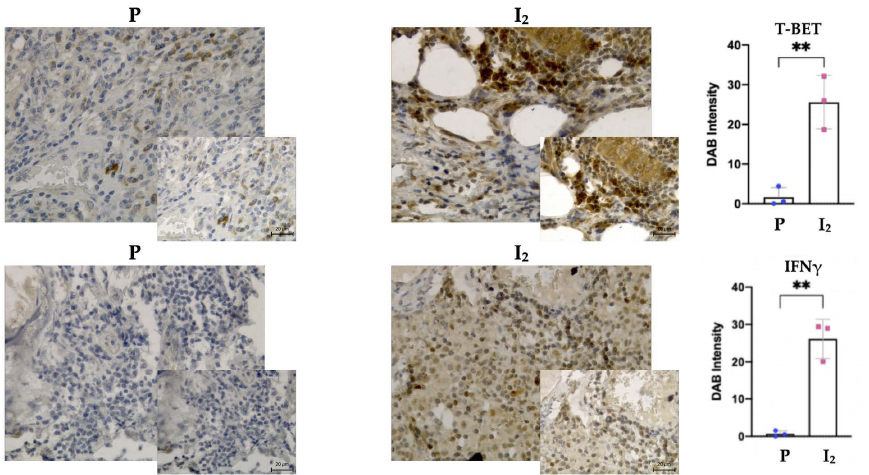
Figure 4. Protein expression of T-BET and IFN γ in individual samples of tumor tissue from early- stage patients (P; Placebo, I 2 ; iodine). Data represent mean ± SD of three independent immunochem- istry experiments from three individual samples. Student’s t -test ** p <